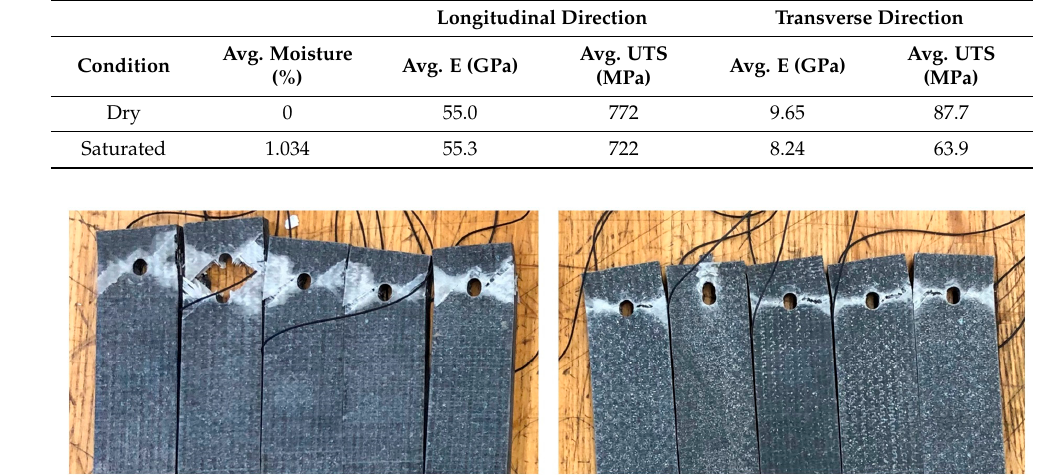
Table 5. Key average results for dry and moisture saturated test coupons.